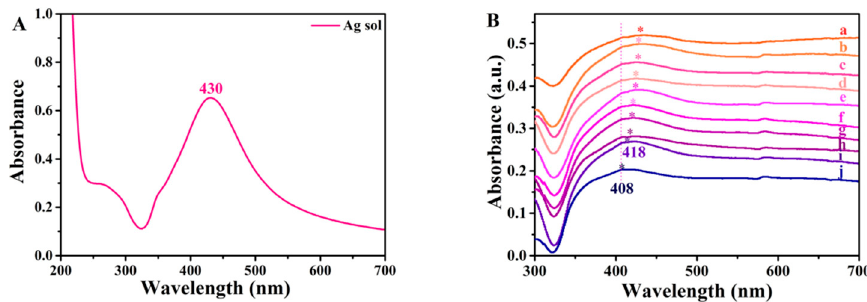
Figure 3. ( A ) UV-Vis absorption spectra of Ag sol, ( B ) Ag/4-MBA/PEDOT:PSS ((a) 1.0%, (b) 0.8%, (c) 0.5%, (d) 0.3%, (e) 0.2%, (f) 0.1%, (g) 0.075%, and (h) 0.05%, (i) Ag/4-MBA and (j) Ag NPs) com- posite systems.